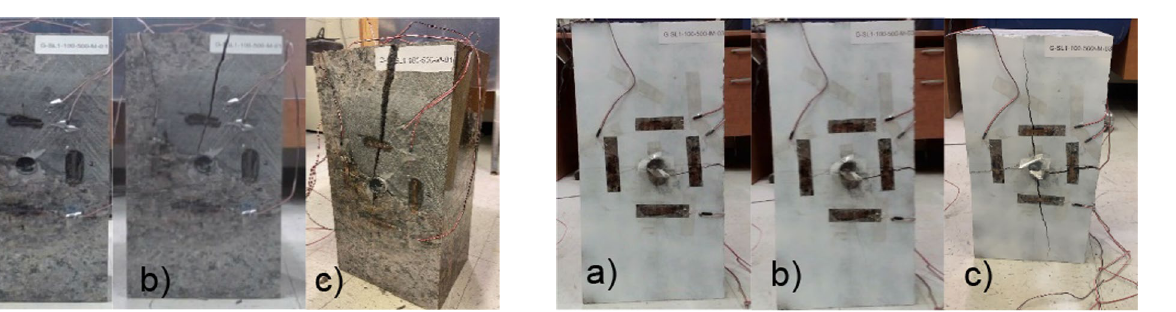
t 0 b Initial breakage at 23 c